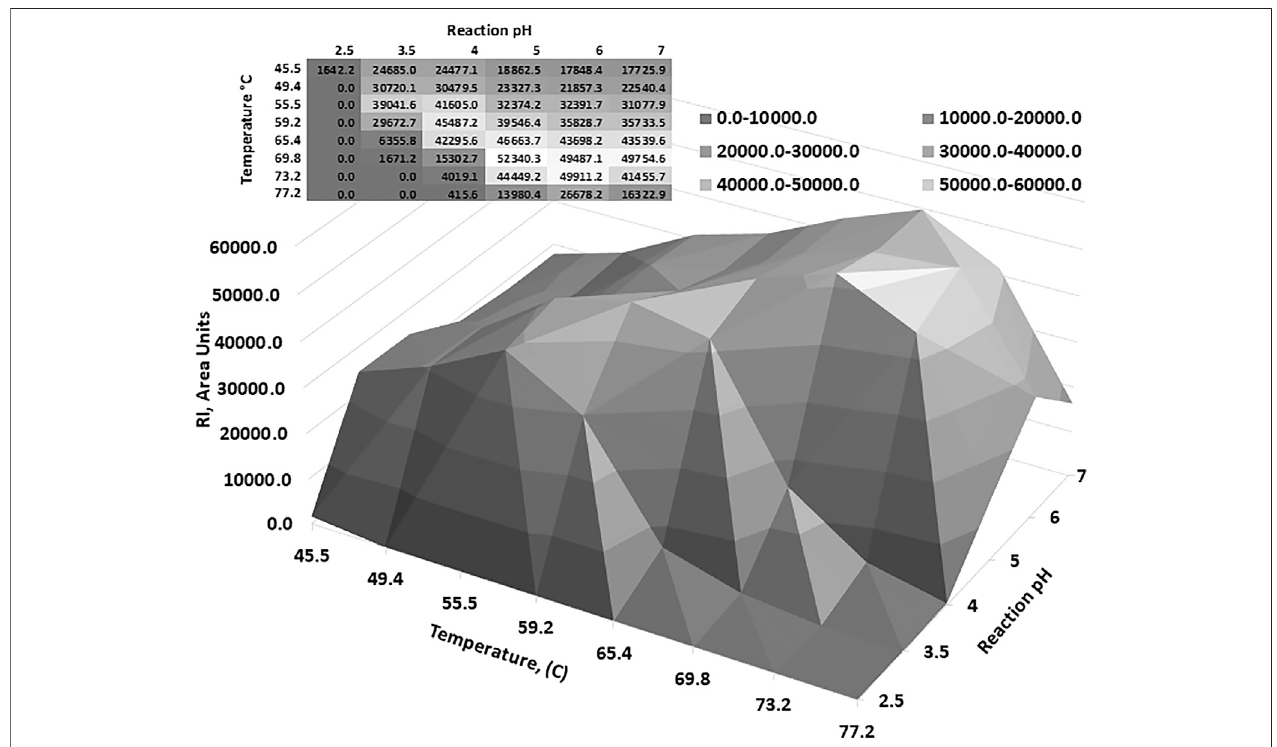
FIGURE3| TobetterunderstandtherelationshipbetweenpHandtemperatureoptimum,afactorialstudywasperformed.Theresultsindicatethatthe Ac Xbh30A- CD SEP is thermostable up to about 70 C and the optimum pH increased as the reaction temperature increased.